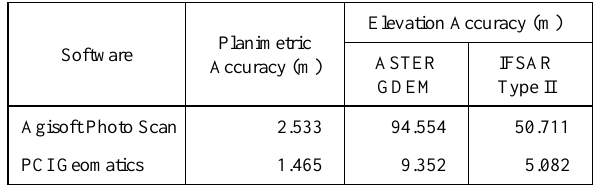
Table 3. Accuracy assessment